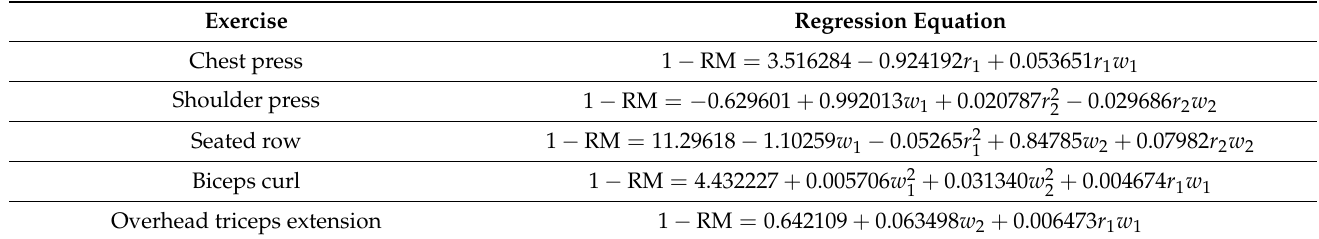
Table 14. 1 − RM estimation equations for the five types of